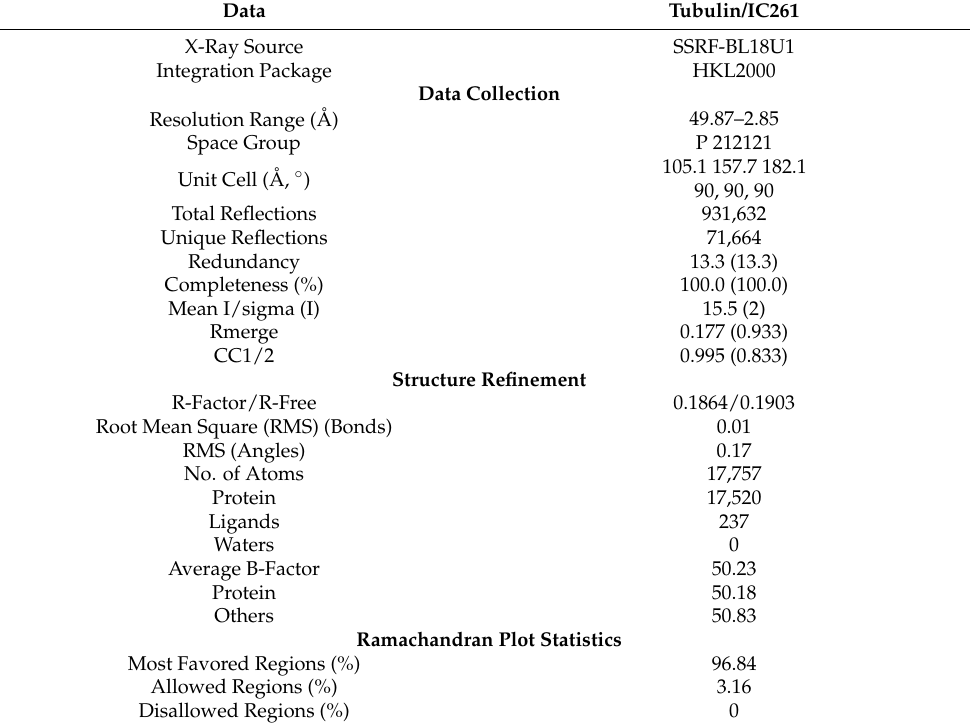
Figure 1. Crystal structure of IC261 complexed with casein kinase 1 (CK1) and tubulin. ( A ) Chemical formula of IC261. ( B ) Binding mode of the CK1-IC261 complex structure. The CK1 is shown in grey and IC261 in yellow. ( C ) The overall structure of tubulin-IC261 complex. The α -tubulin is shown in blue, β -tubulin in green, guanosine triphosphate (GTP) in purple, and IC261 in yellow. ( D ) The electron densities of IC261. The Fo-Fc map is shown grey and contoured at 2.0 σ . Table 1. Data collection and refinement statistics for X-ray structure.